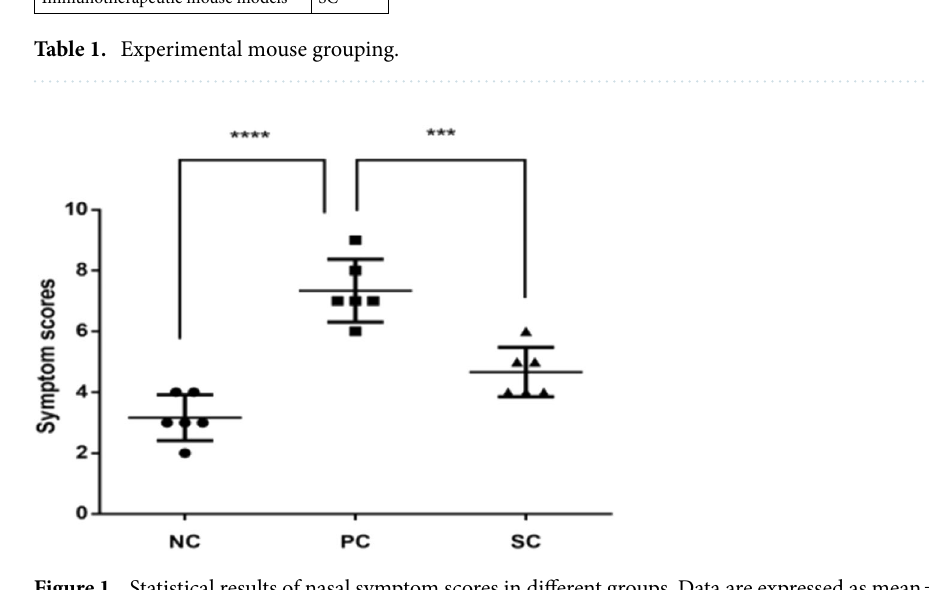
Figure 1. Statistical results of nasal symptom scores in different groups. Data are expressed as mean ± standard deviation. Compared with the NC group, SC group, and PC group, ***P < 0.001, ****P <